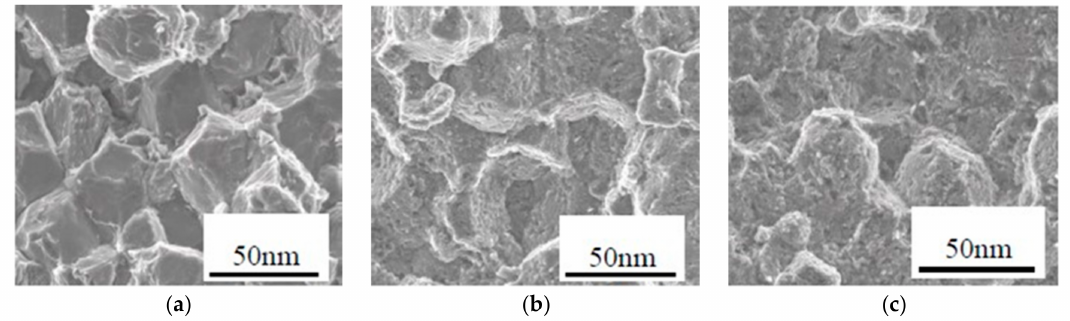
Figure 14. SEM micrograph of the fracture surface of AA6061 / 5 vol.% N-SiCp composites produced sintered at 450 ( a ), 550 ( b ), 600 ◦ C ( c ),